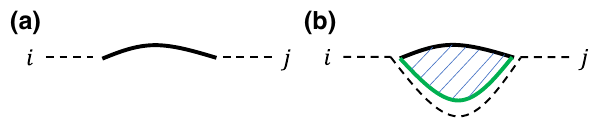
FIG. 10. (a) Boundary conditions and (b) the bulk path integral according to the rules of Ref. [17]. for evaluating (ρ R ) ij